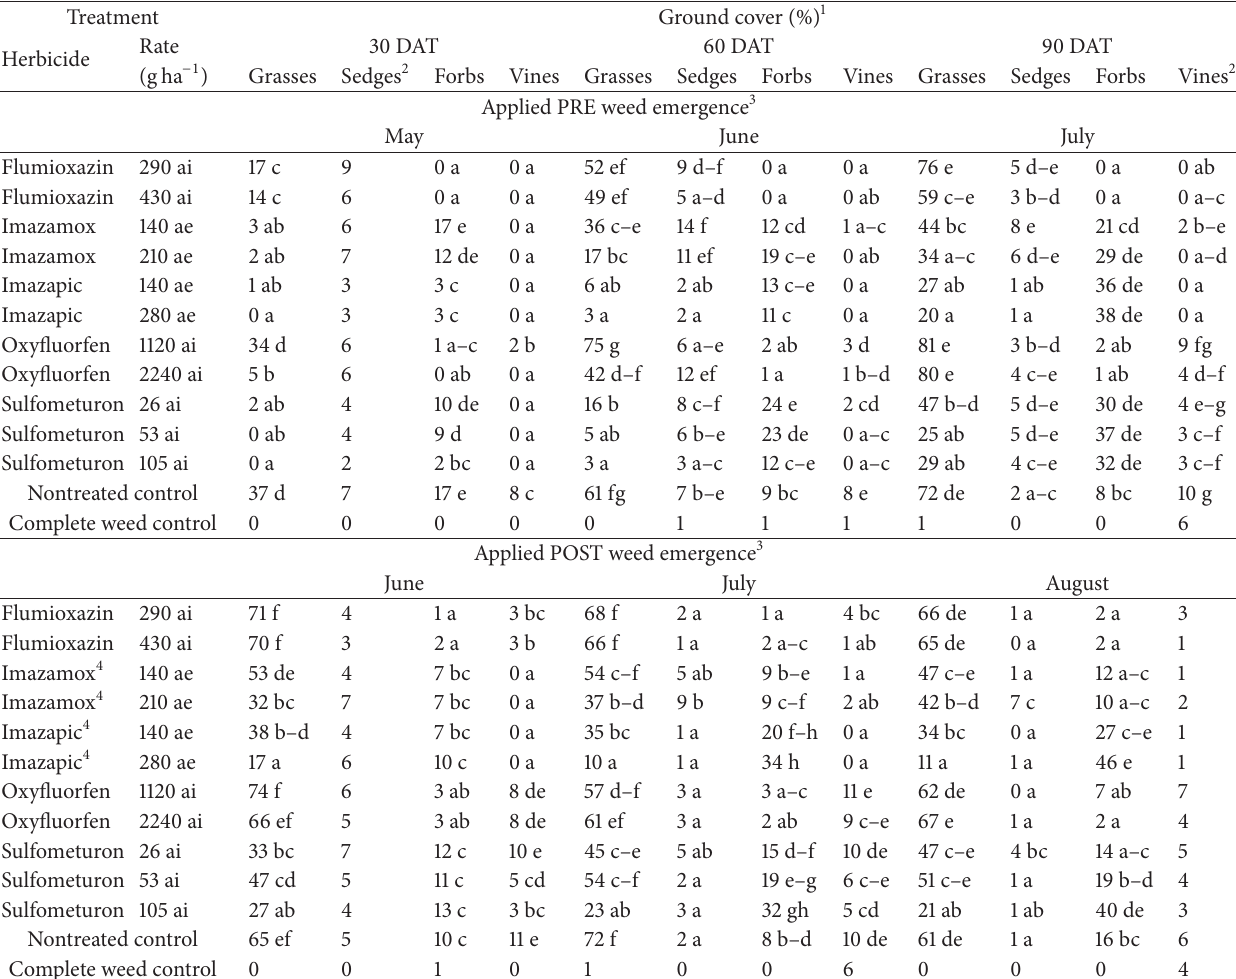
Table 3: Prevalence of ground cover by vegetation groups 30, 60, and 90 days after treatment (DAT) for herbicides applied over newly planted Eucalyptus urograndis rooted cuttings either prior to weed emergence (PRE) or after weed emergence (POST). Treatments were evaluated at the end of the month indicated for each application timing and periodic